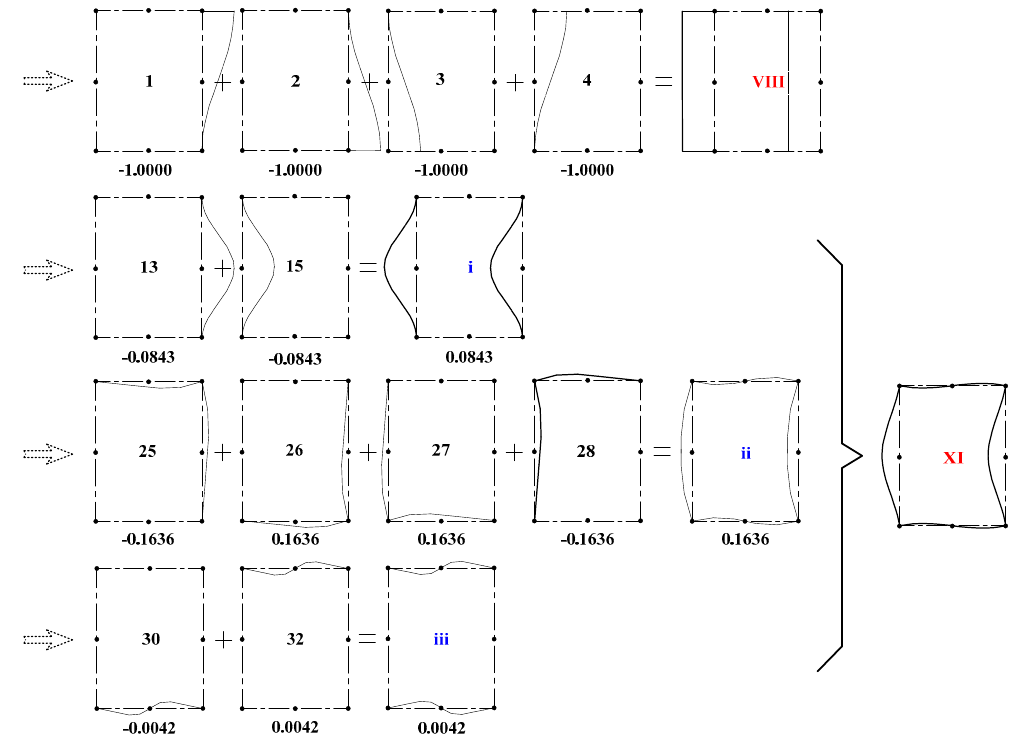
Figure 8. Assemblage of in-plane mode family for the first modal of a thin-walled structure with a rectangular hollow cross-section.